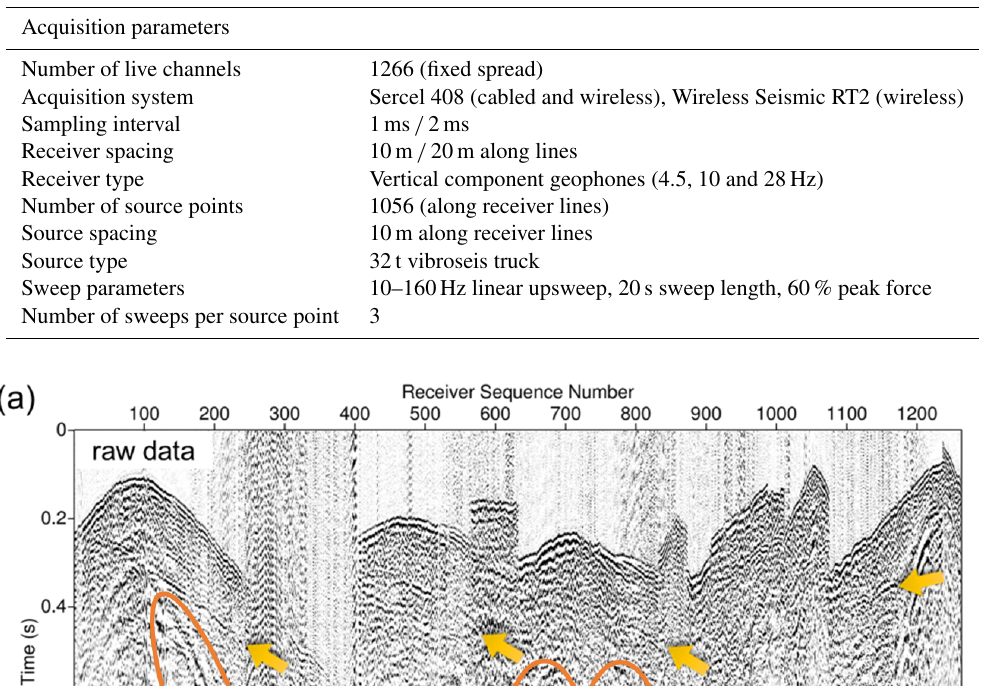
Table 1. Acquisition parameters of the 3D reflection seismic survey.